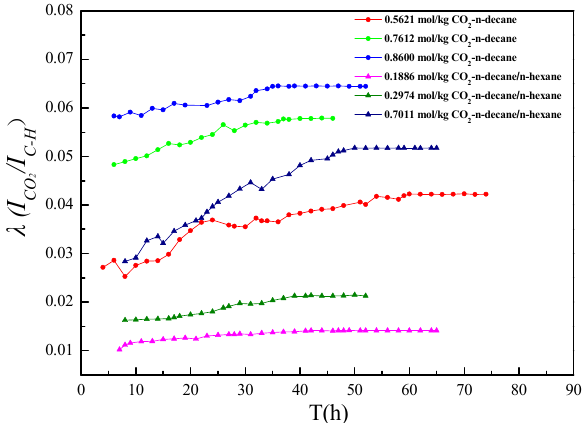
Figure 2. Variation of the Raman peak intensity ratios of mixture with di ff erent CO 2 concentrations and time.